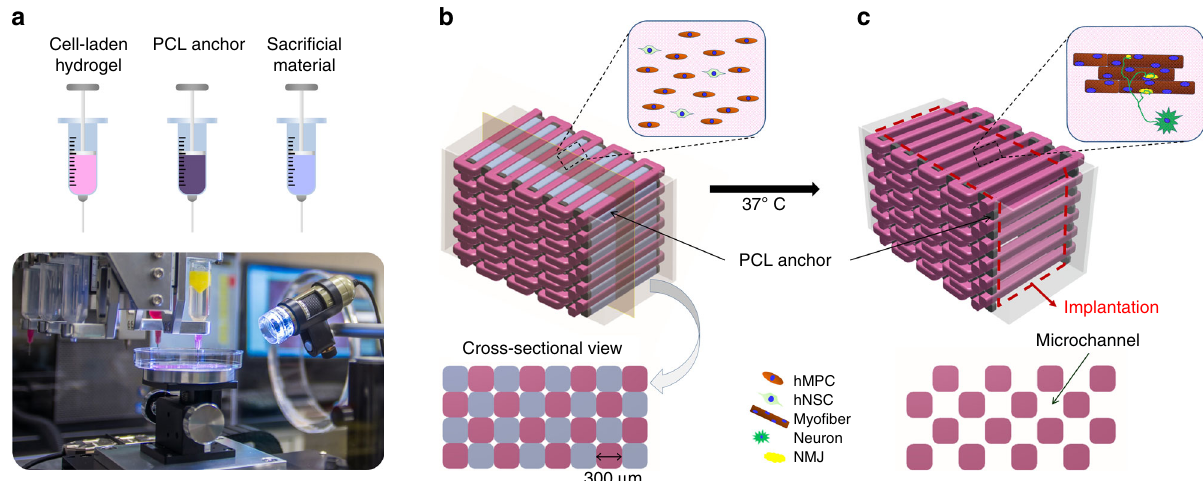
Fig. 2 Bioprinting of human skeletal muscle constructs. a Three components (cell-laden bioink, polycaprolactone (PCL), and sacri fi cial bioink) were printed in a layer-by-layer fashion using our custom 3D bioprinting system. b Design concept using 3D CAD modeling of the bioprinted construct. The cell- laden bioink containing hMPCs and/or hNSCs, the acellular sacri fi cing bioink, and the supporting PCL pillar were deposited by the multi-dispensing modules. c Microchannels in the constructs created after the removal of the sacri fi cial patterns to maintain the viability of printed